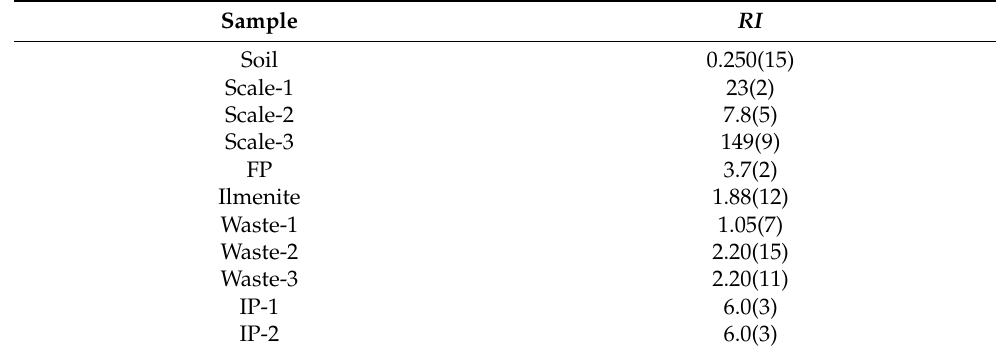
Table 5. Radioactive index ( RI ) values calculated for each sample analyzed in this study as well as for a typical soil (Soil), where a sample can be classified as NORM or non-NORM when RI > 1 or RI ≤ 1, respectively.